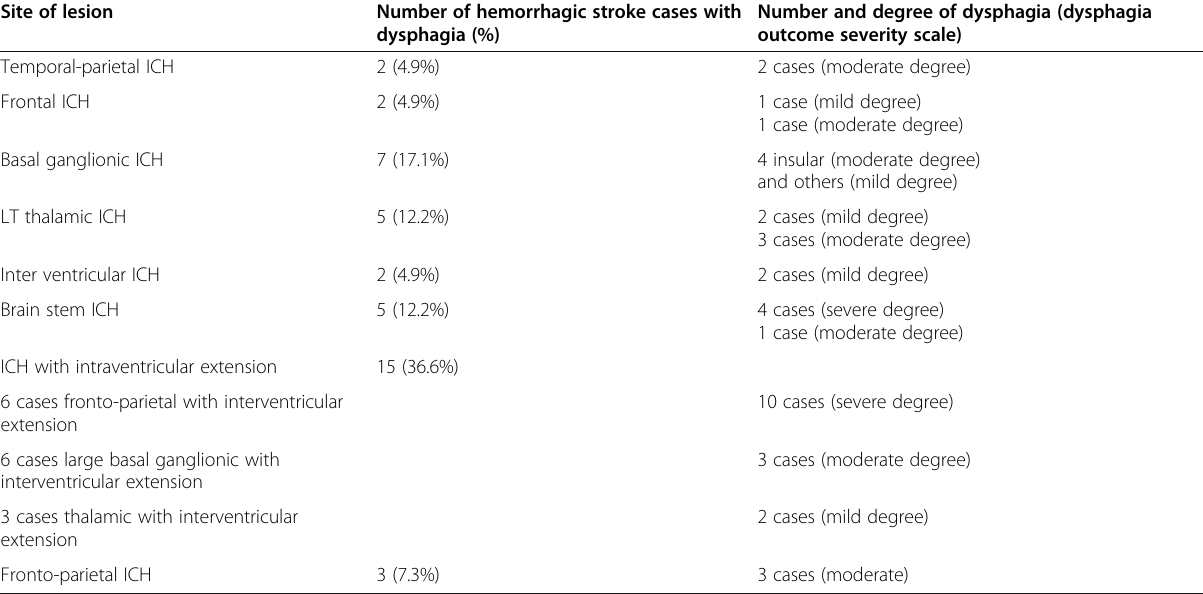
Table 6 The presence and the degree of dysphagia (DOSS score) in hemorrhagic stroke in correlation to radiological site of lesion